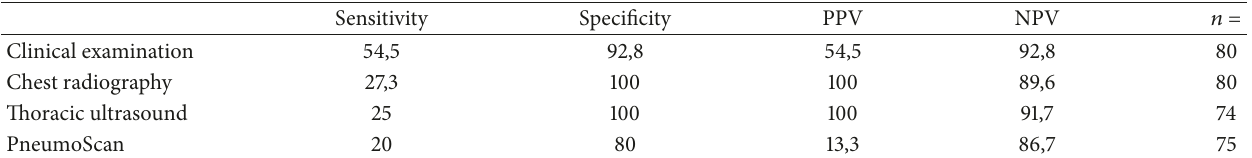
Table 4: Diagnostic accuracy of all investigated methods (all data in percent); PPV = positive predictive value; NPV = negative predictive value.